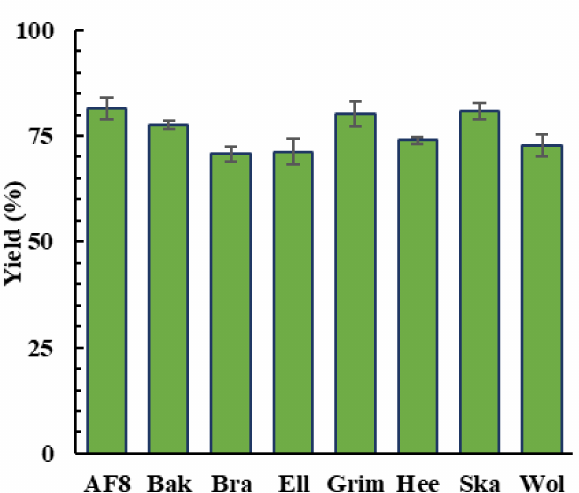
Figure 1. Comparison of the yield of bio-oils obtained via acid-catalyzed liquefaction of poplar